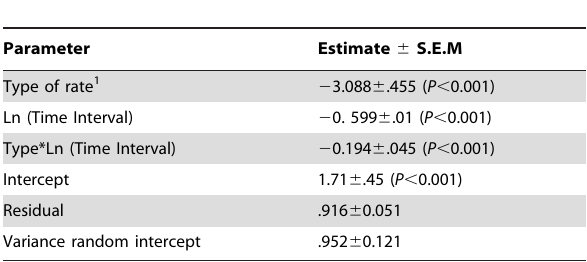
Table 2. Estimates of fixed effects and covariance parameters for the linear mixed model of interaction between rate, type of rate (biological or cultural rates), and time interval.